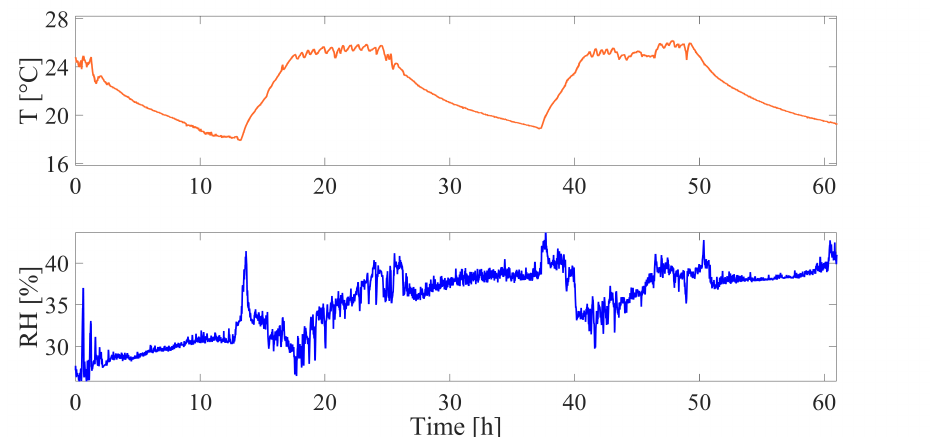
Figure 9. Microclimate data collected during the stem growth trial: temperature (T) trend versus time is showed in the top plot and relative humidity (RH) trend versus time is showed in the bottom plot during the entire